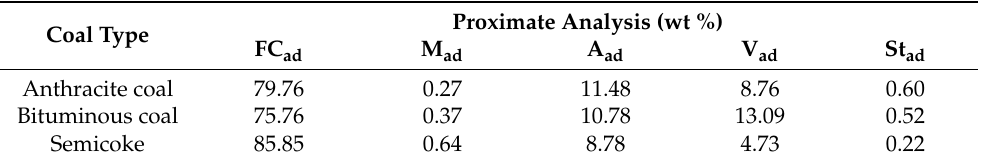
Table 1. Composition analysis of three kinds of pulverized coal (wt